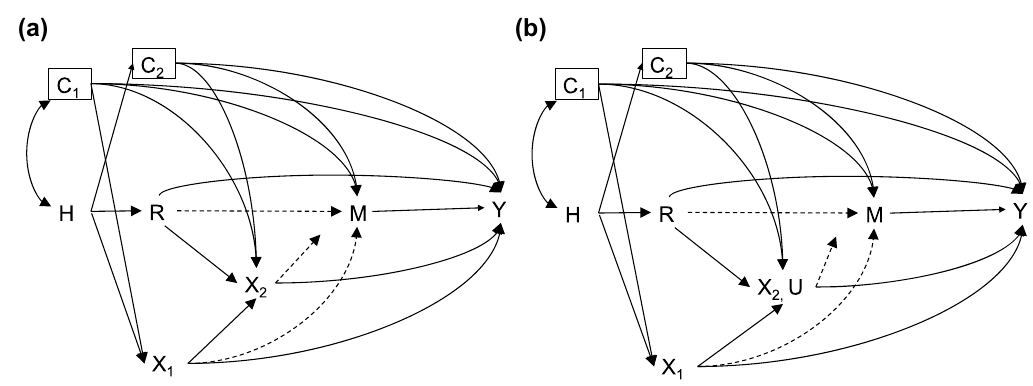
Figure 1: Directed acyclic graph [ 19 ] : ( a ) when no unobserved confounder exists and ( b ) when unobserved confounder U exists. Note. ( 1 ) Diagram represents the relationship between race and gender intersectional status R , cardiovascular health Y , and education M , as well as history H , age C 1 , genetic vulnerability C 2 , childhood SES X 1 , and childhood abuse X 2 . ( 2 ) Placing a